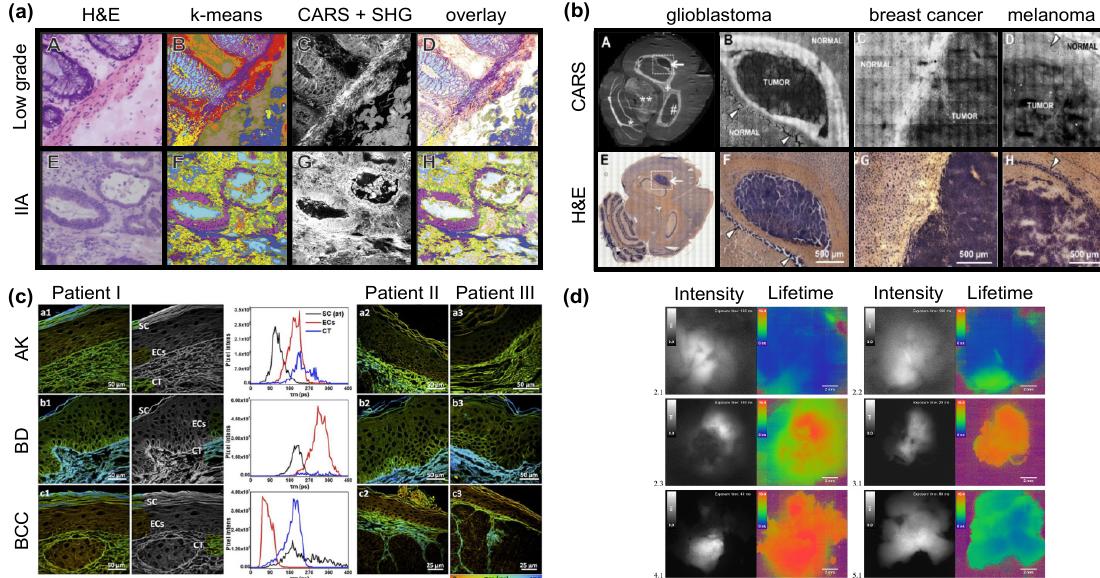
Figure 2. Application of Raman and FLIM imaging to discriminate tumor tissues. ( a ) Imaging of tissues from patients with low grade (A–D) and stage IIA (E–H) colorectal carcinoma. H&E staining (A, E), K-means clustering result of CARS spectra in the 2700–3000 cm − 1 region (B, F), combined images of second harmonic generation (SHG) intensities at 408 nm and CARS signals at 2850 cm − 1 (C, G) and overlay of k-means clustering with SHG and CARS (D, H) are shown. Reprinted with permission from [110]. ( b ) CARS (A–D) and H&E (E–H) imaging of mouse brain sections with an experimental human U87MG glioblastoma (A, B), breast cancer metastasis induced by MCF-7 cells (C) and melanoma induced by A375 cells (D). White matter of brain and normal tissue appears brighter in CARS images, while the tumor regions are darker. Reprinted with permission from [119]. ( c ) FLIM images of skin sections from actinic keratosis (AK), Bowen’s disease (BD), and basal cell carcinoma (BCC). The corresponding color-coding scheme ranges from red (0 ps) to blue (450 ps). For each patient and disease type, the mean fluorescence lifetimes ( τ m) of stratum corneum (SC, black line), epithelial cells (EC, red line), and dermal connective tissue (CT, blue line) were compared. Reprinted with permission from [124]. ( d ) 5-ALA fluorescence intensity (grey scale) and FLIM images (color) of brain tumor samples. Infiltrating tumor tissues characterized by increased lifetimes in green (2.1, 2.2), focal glial cell infiltration (2.3), strong 5-ALA positive fluorescence, according to increased lifetimes in red (3.1, 4.1) and glioblastoma with minimal infiltration of tumor cells are demonstrated (5.1). Areas in purple correspond to areas outside of the sample. Scale bars are equal to 2 mm. Reprinted with permissions from [125].